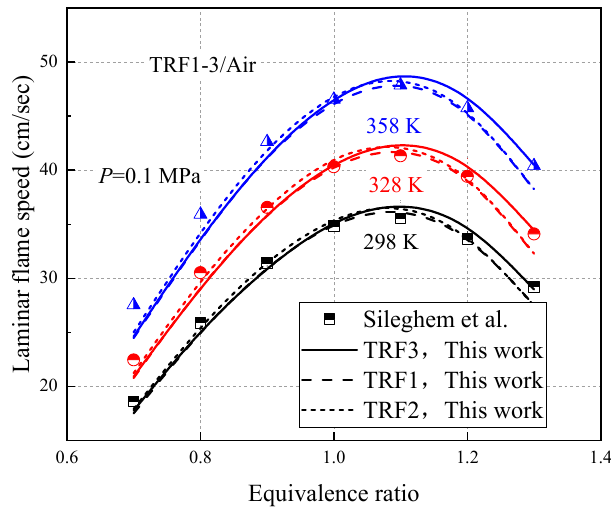
Figure 11. Verification of the laminar flame speed of TRF.